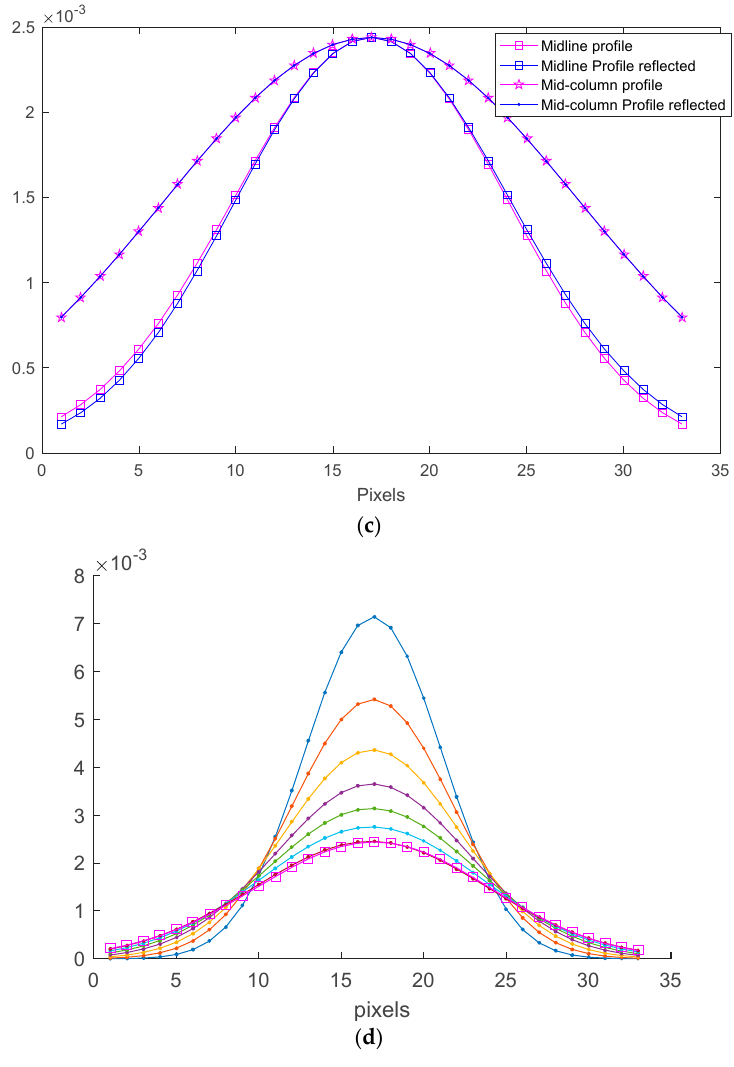
Figure 9. ( a ) construction of a 33 × 33 stencil Gaussian kernel at a position near the edge of FoV ( b ), using successive convolutions of an initial smaller 11 × 11 kernel (at the same pixel). ( b ): the constructed kernel and ( c ) its line profiles along the iso-azimuth (midline) and iso-elevation (mid-column) direction, ( d ): The midline of the intermediately generated kernels up to the 8th iteration are shown with dots. The midline of the directly constructed kernel is shown with “ □ ”. The result of successive convolutions of the initial Gaussian kernel.